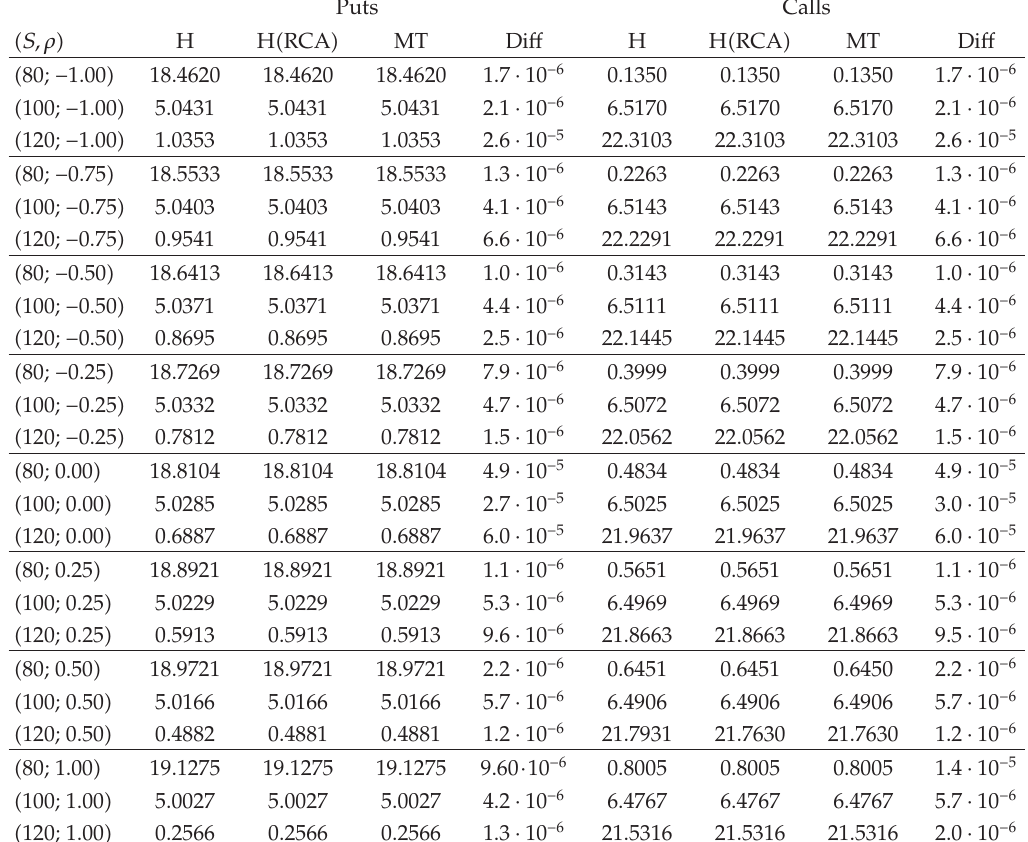
Table 2: European option prices in Heston’s stochastic volatility model for di ff erent asset prices S and correlations ρ . Fixed parameters are X (cid:8) 100, r (cid:8) 0 . 05, q (cid:8) 0 . 02, V (cid:8) 0 . 04, κ (cid:8) 2, θ (cid:8) 0 . 05, ξ (cid:8) 0 . 2, and c (cid:8)